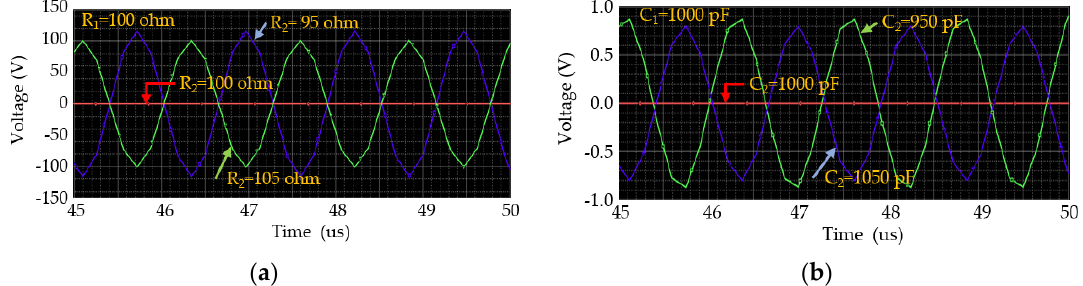
Figure 12. V AB of the Maxwell bridge ( a ) when R 1 and R 2 do not match and ( b ) when C 1 and C 2 do not match.